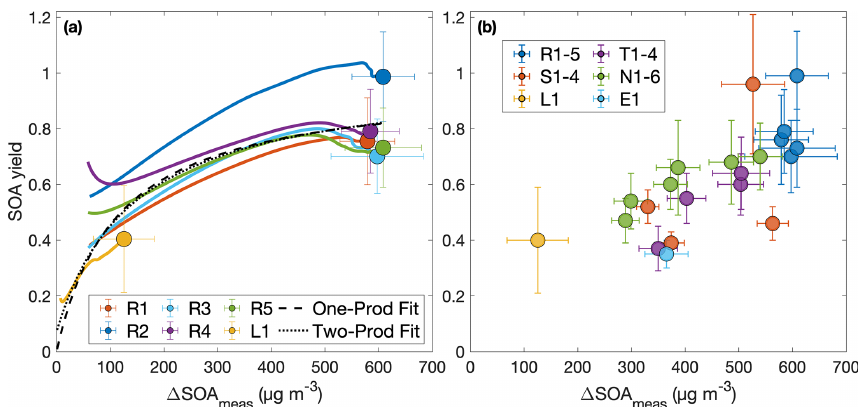
Figure 3. Secondary organic aerosol yields as a function of organic aerosol formed (a) throughout experiments performed under similar initial conditions (R1–R5 and L1) and (b) at the end of oxidation for experiments with quantitative SOA yields. In panel (a) , the first 30min of oxidation are removed due to low signal and large uncertainties in SOA yield. Note that the experiment run at a lower oxidation rate (L1) nearly matches the outcomes of those run under otherwise similar conditions (R1–R5), though the discrepancy may be due to the slightly lower temperature of experiment L1 (286K compared to 291K). The measured SOA yield appears to depend on the organic aerosol mass concentration, (cid:49) SOA meas , which indicates that particle partitioning is important for SOA yield determination. Panel (a) also includes a one-product and two-product fit to the